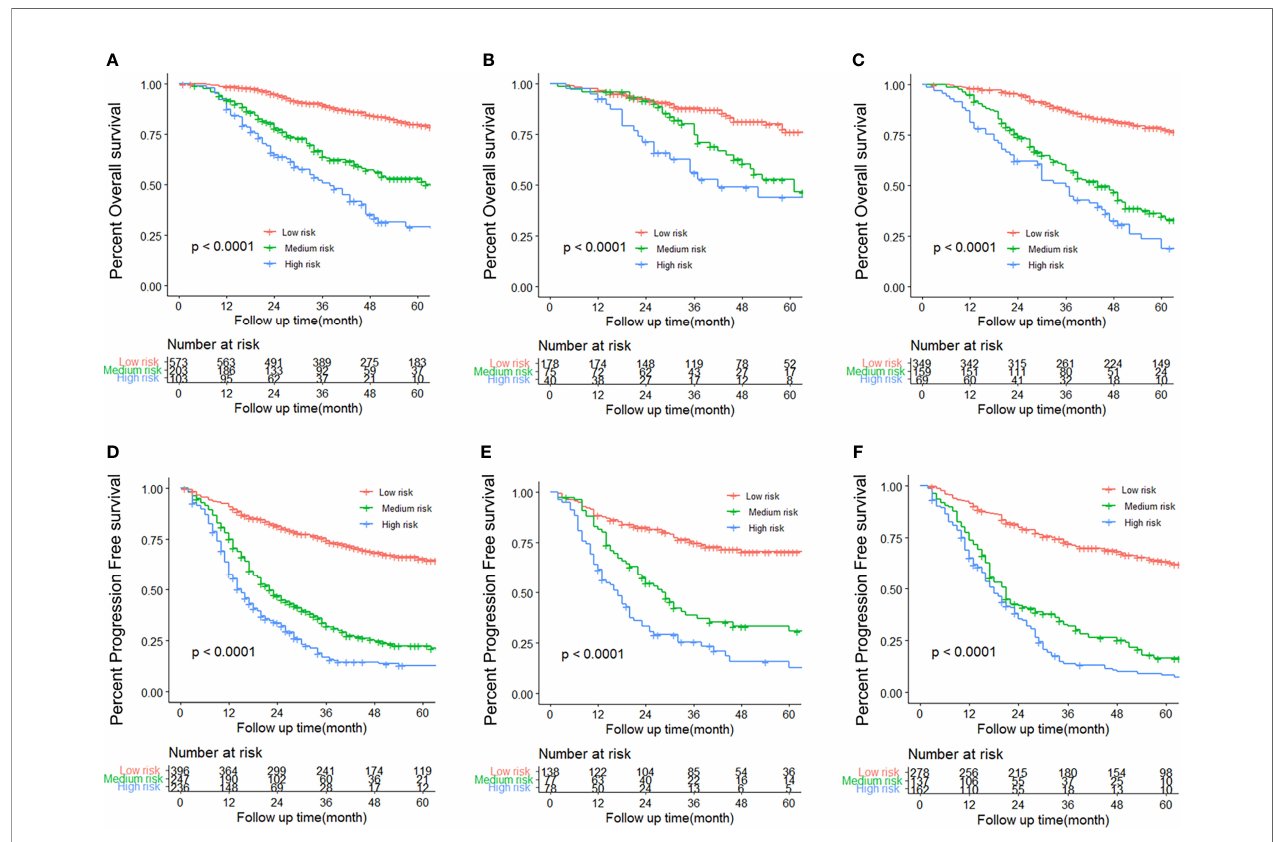
FIGURE 6 | Kaplan – Meier survival curves for each subtype of patients, estimating progression-free survival (PFS) in the training (A) , internal validation (B) , and external validation (C) cohorts, and overall survival (OS) in the training (D) , internal validation (E) , and external validation (F)